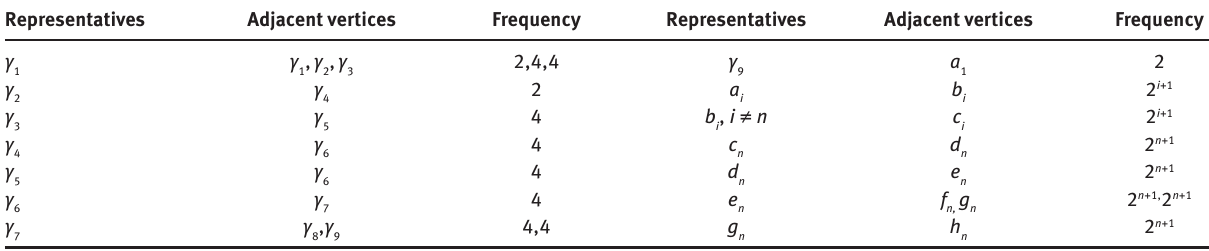
Table 7: The edge partition with respect to the pairs of end vertices of sets C and D , degree of each edge and their frequency of occurrence. Edge